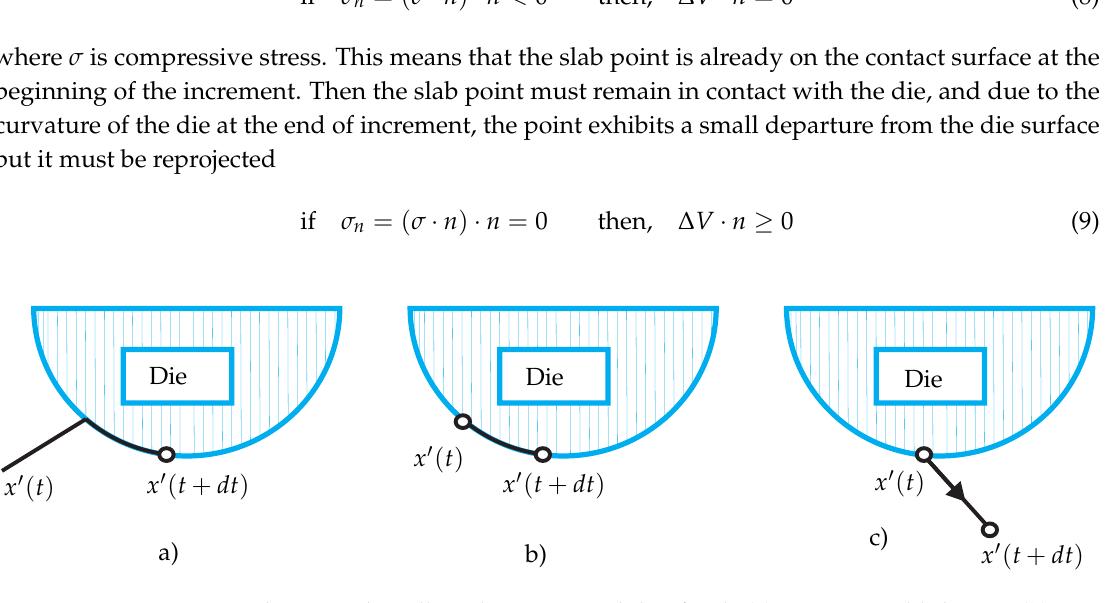
Figure 3. Incremental contact the rolling die is assumed that fixed. ( a ) Contact establishment, ( b ) Gliding contact, and ( c ) Loss of contact